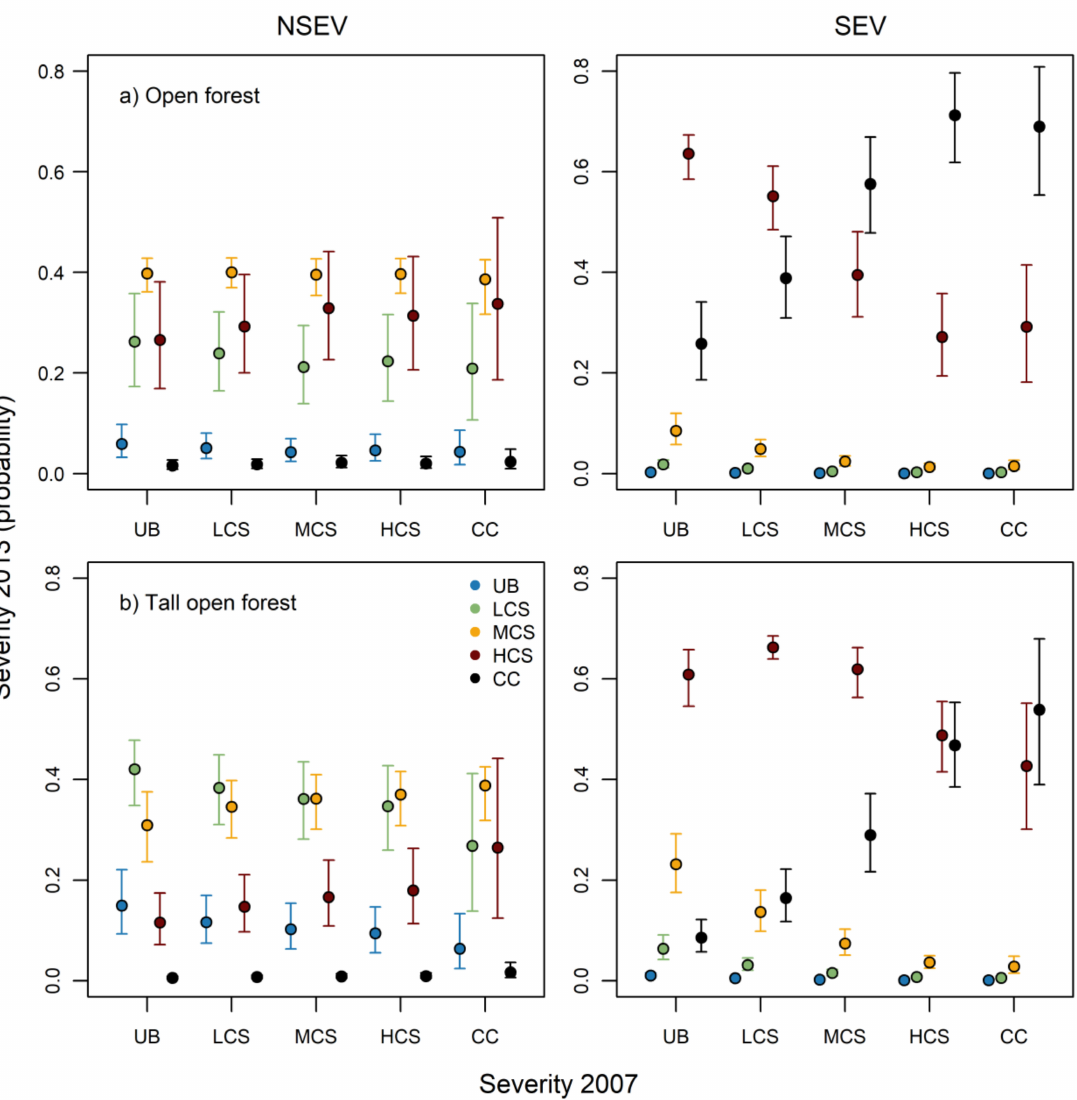
Figure 3. The effect of the severity of the 2007 fire ( x -axis) on the probability of each severity class occurring during the 2013 fire ( y -axis) for ( a ) open forest and ( b ) tall open forest types under nonsevere (NSEV) and severe (SEV) fire weather. Points show the mean and error bars are the 95% credible intervals. The fire severity codes are unburnt (UB), low canopy scorch (LCS), moderate canopy scorch (MCS), high canopy scorch (HCS) and canopy consumption (CC). Slope, aspect, topographic position (TPI), latitude and longitude have been held constant at their mean